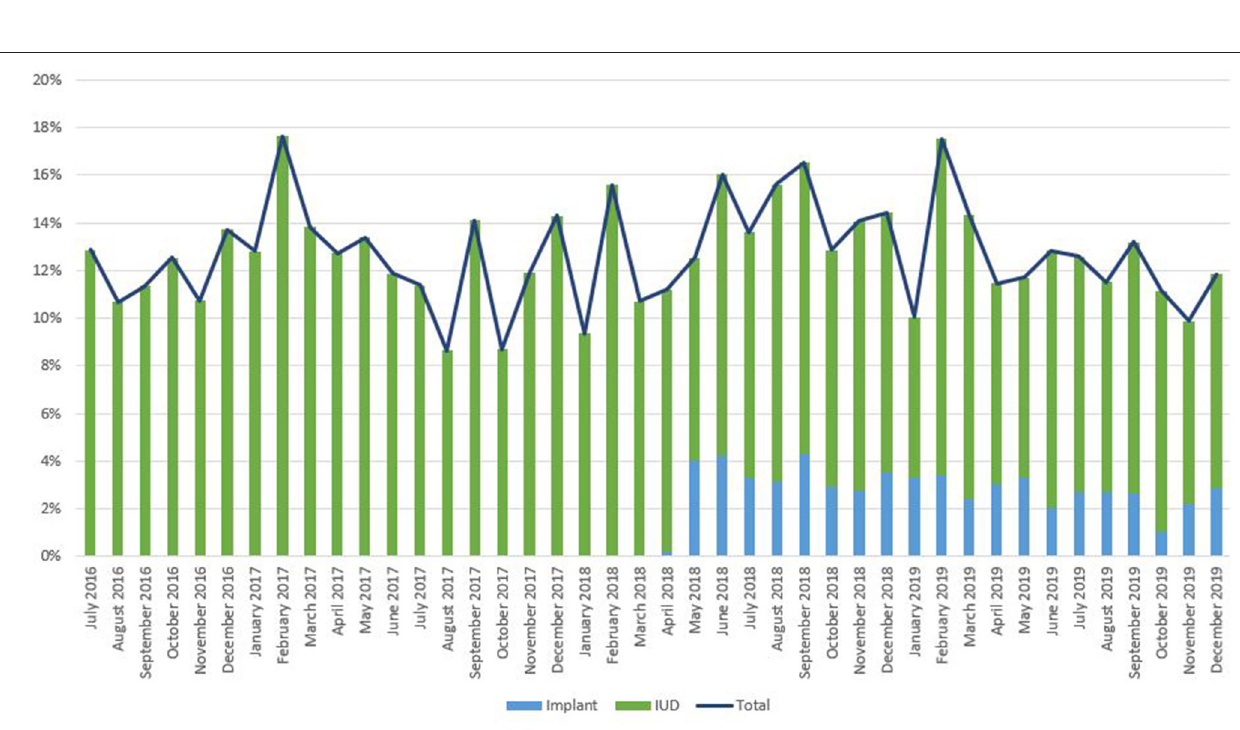
Frontiers in Global Women’s Health |